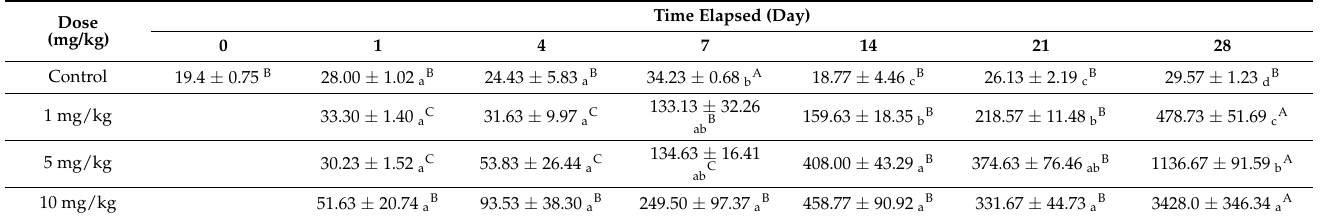
Table 2. Bioaccumulation of methylmercury ( µ g/kg) in liver of hybrid grouper fed with various concentrations of methylmercury for 28 days.